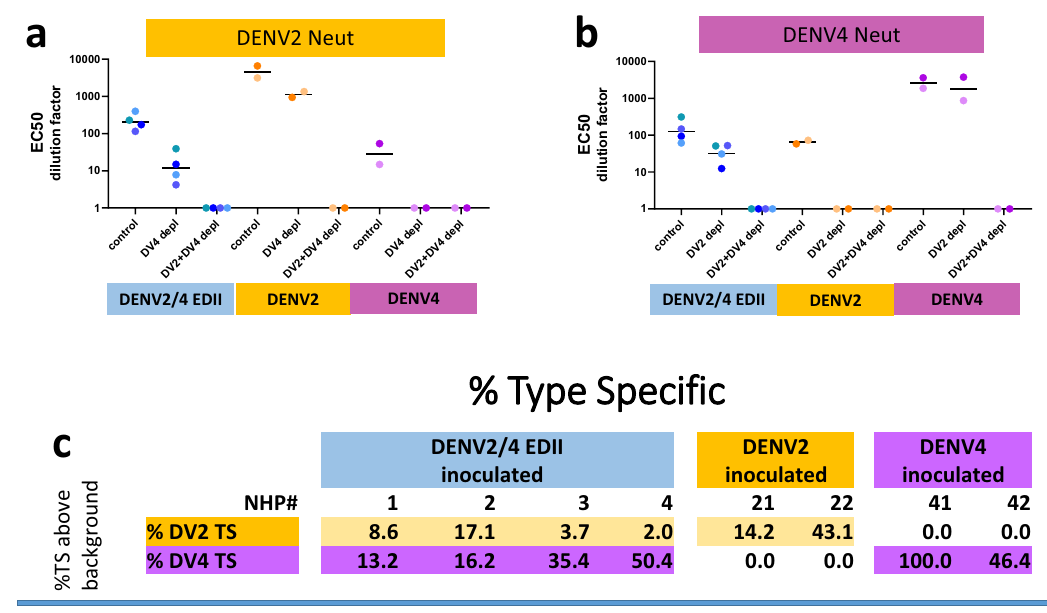
Fig. 5 | DENV2/4EDII induced Type Speci fi c (TS) antibodies to both parental DENV2 and DENV4 strains. a Type-Speci fi c Abs to DENV2 were identi fi ed in DENV2 sera and DENV2/4EDII sera but not DENV4 sera. Sera was depleted by BSA(control), DENV2 or DENV2+DENV4 virions. Background (DV2+DV4 depl) subtracted Vero-81 FRNT EC 50 values are shown. Individual EC 50 values are shown with a bar at the median value. Neutralization curves for each EC 50 are shown in supplementary Fig. 4. b Type-Speci fi c Abs to DENV4 were identi fi ed in DENV4 and DENV2/4EDIIserabutnotDENV2sera.SerawasdepletedwithBSA(control),DENV4